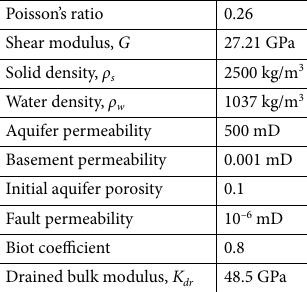
Table 1. Parameters used in the coupled poro-mechanical